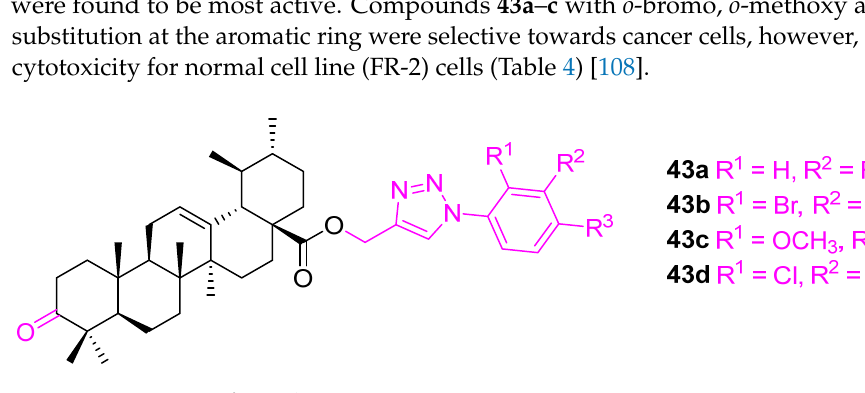
Figure 28. Structure of 43a – d . Table 4. IC 50 values ( µ M) of compounds 43a – d against various cell